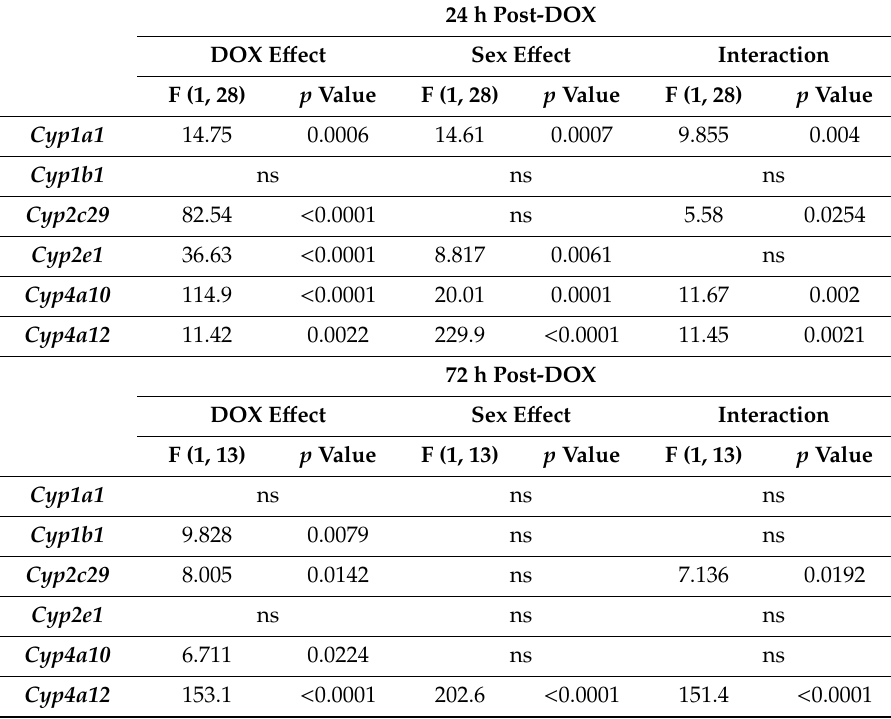
Table 1. Two-Way ANOVA for CYP Gene Expression Data.